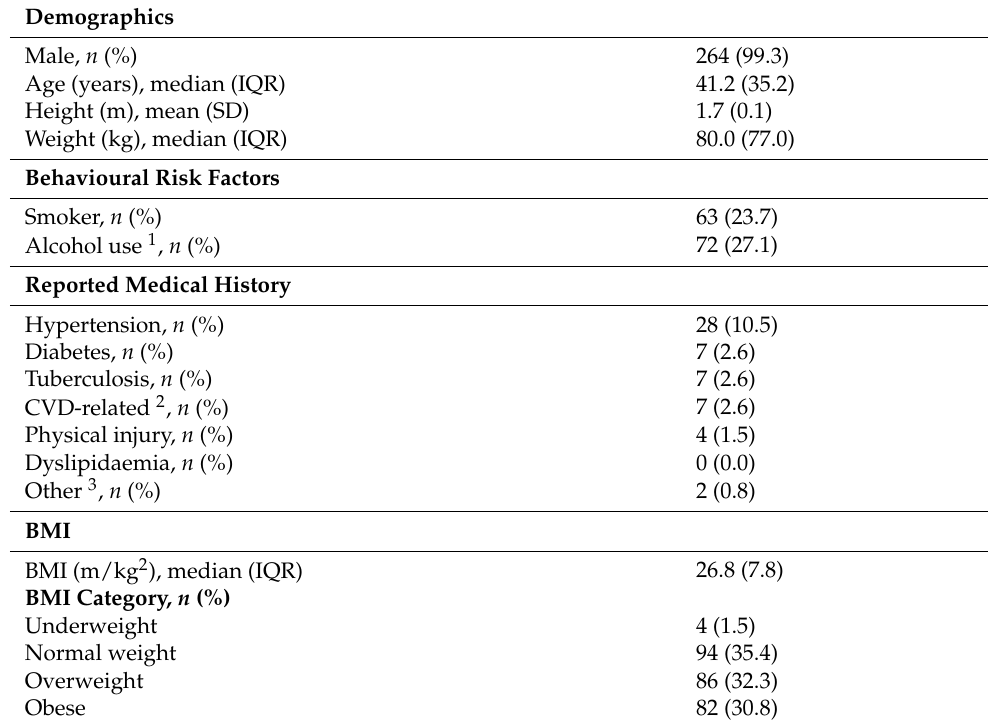
Table 1. Baseline demographics and occupational health assessment findings of bus drivers in South Africa, 2007 to